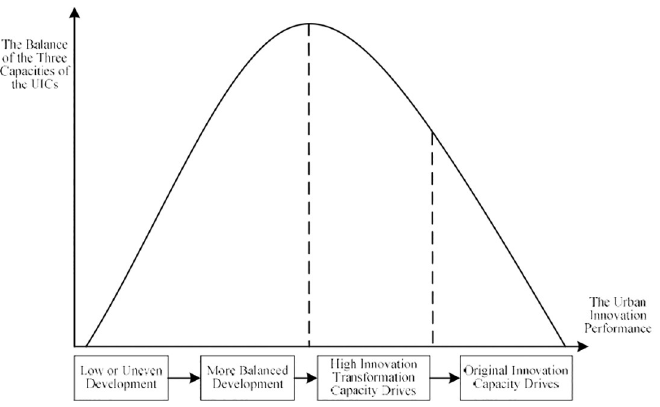
Fig 8. Relationship between the equilibrium degree of the three capabilities of the UIC and the innovation performance. Source: The authors.